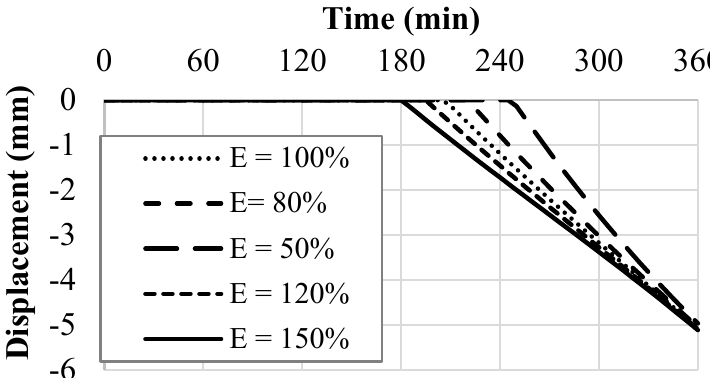
Figure 20. Young’s modulus sensitivity analysis on radial displacement.